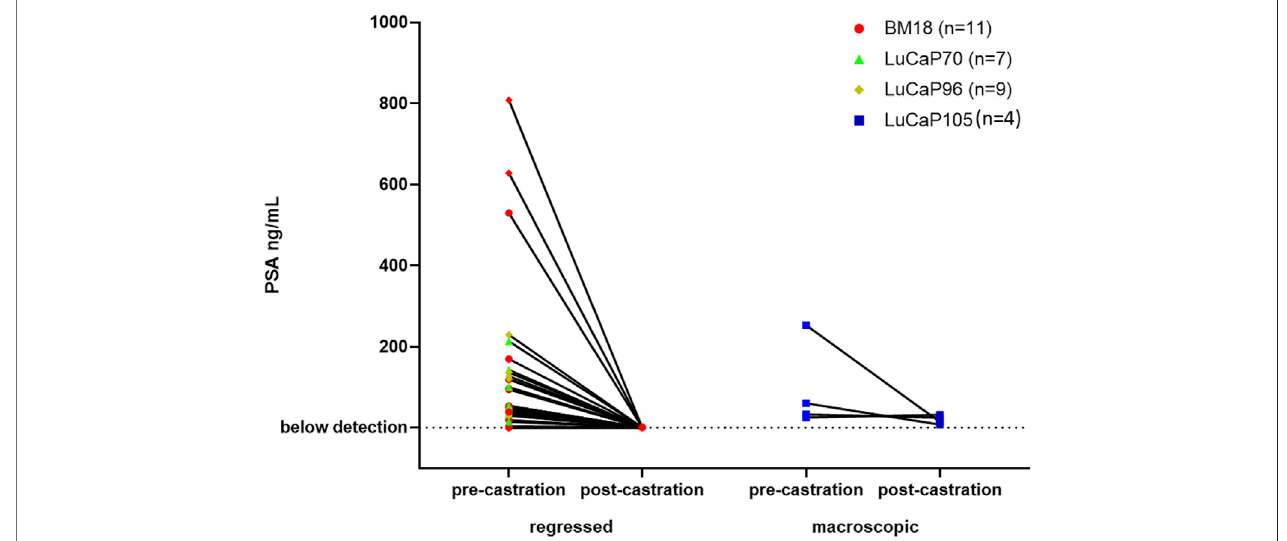
FIGURE 1 | Serum PSA levels of mice pre- and post- castration. PSA levels after castration were very low or not detected in mice with regressed tumours. Post- castration PSA levels were signi fi cantly higher in mice where no tumour regression was observed compared to mice with regressed tumours (unpaired t -test, p = 0.0007). Tumours that decreased in size from their pre-castration measurement and weighed less than 0.3 g were classi fi ed as